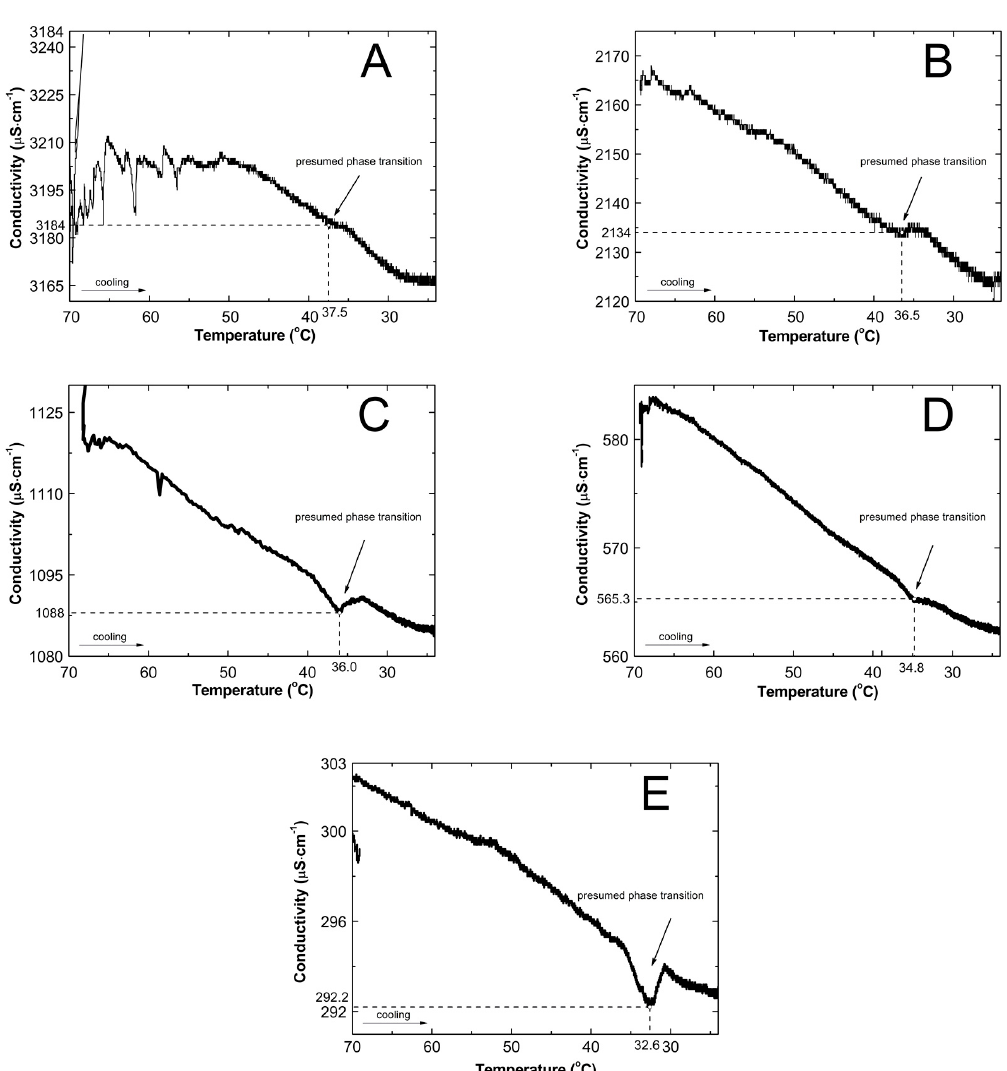
Figure 3. The conductivity as a function of temperature in the reaction mixtures of P1 ( A ), P2 ( B ), P3 ( C ), P4 ( D ), and P5 ( E ) during cooling of the system after the synthesis procedure.